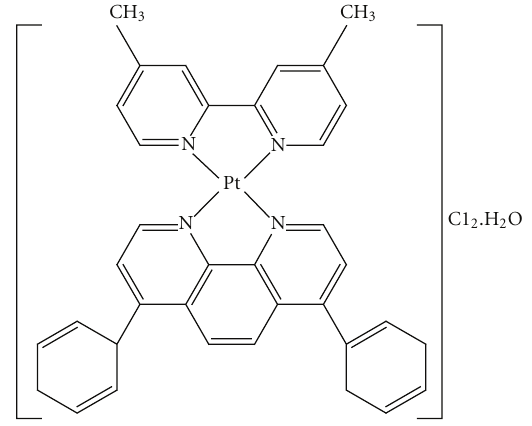
Figure 1: The structure of [Pt(DMP)(DIP)]Cl 2 · H 2 O complex. 2.5